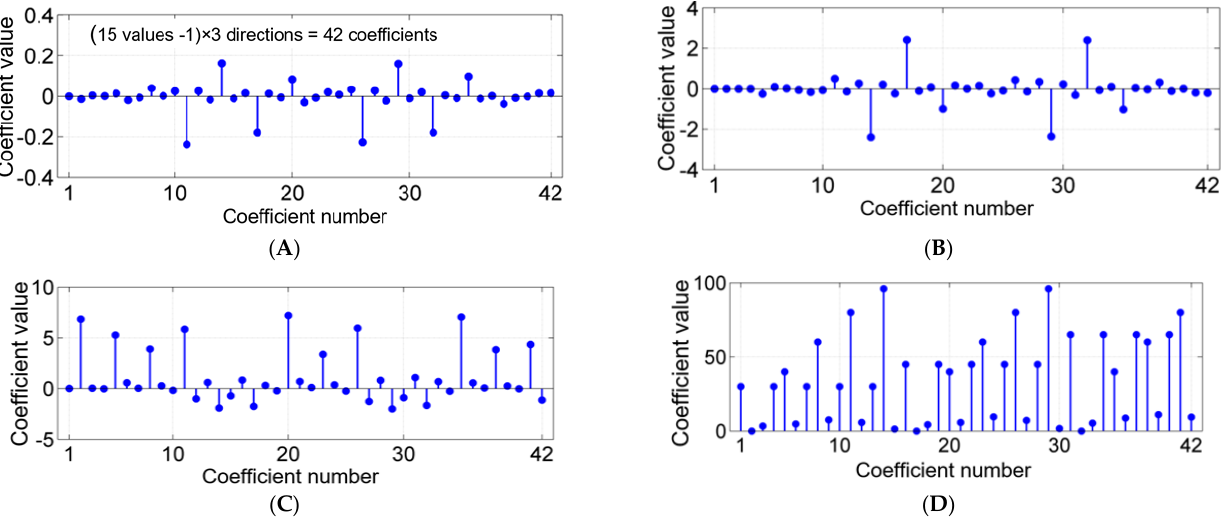
Figure 2. Coefficients of the mathematical model for TPC values in GME at different temperatures and concentrations of the hydroalcoholic solution, based on the cubic spleen functions: ( A ) coefficient c 1i ; ( B ) coefficient c 2i ; ( C ) coefficient c 3i ; ( D ) coefficient c 4i .